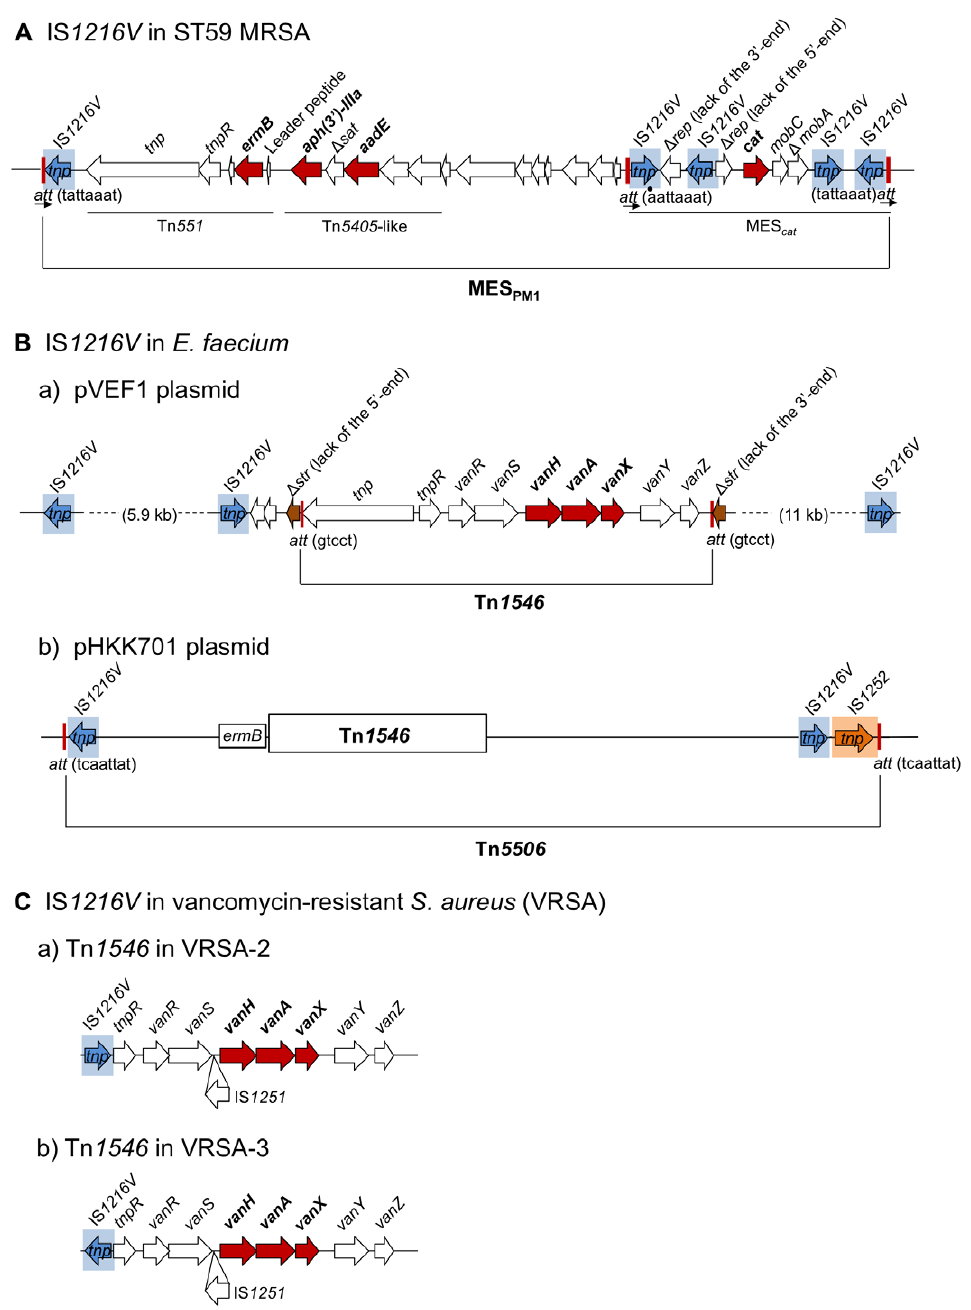
Figure 6. Comparison of IS 1216V -containig mobile elements in MRSA and E. faecium . The structures of IS 1216V -containing mobile elements: A, MES PM1 determined in this study; B, Tn 1546 and Tn 5506 in E. faecium ; C, vancomycin resistance transposon Tn 1546 in VRSA. The IS 1216V region with the transposase gene ( tnp ) is shaded in blue. The att site is indicated by a vertical red line. The data for pVEF1 are from GenBank (GenBank accession number AM296544). The data for pHKK701 and Tn 1546 in VRSA-2 and VRSA-3 were obtained from previously described maps [31,32].